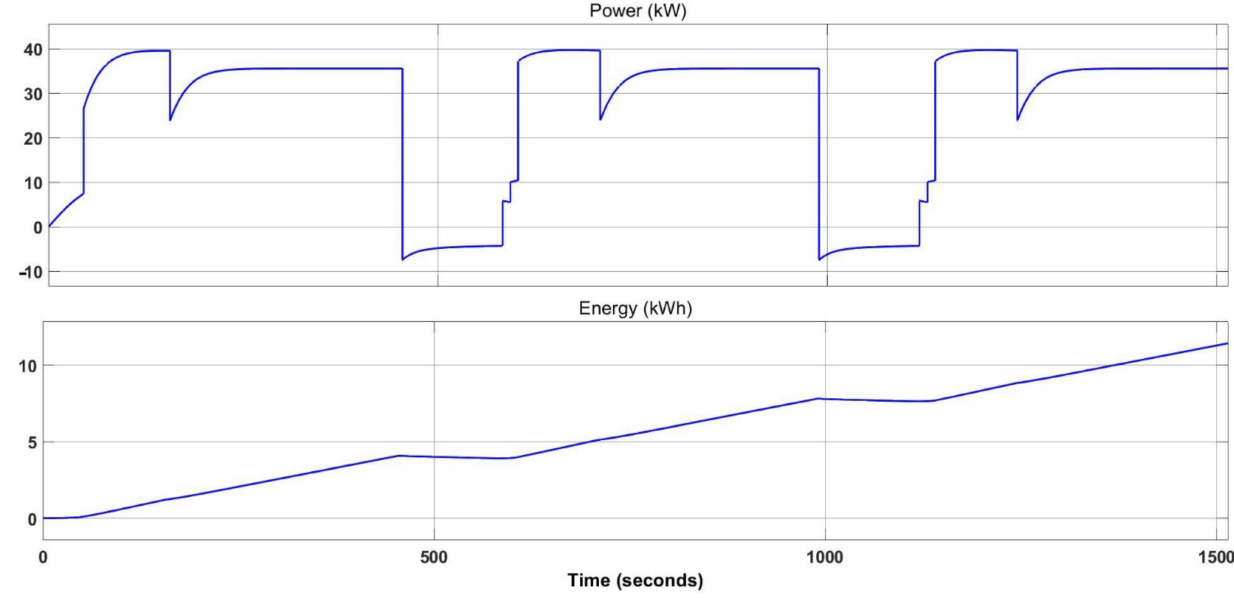
Figure 8. Power demand and energy consumption of electric Diamond DA20 Katana—touch-and-go